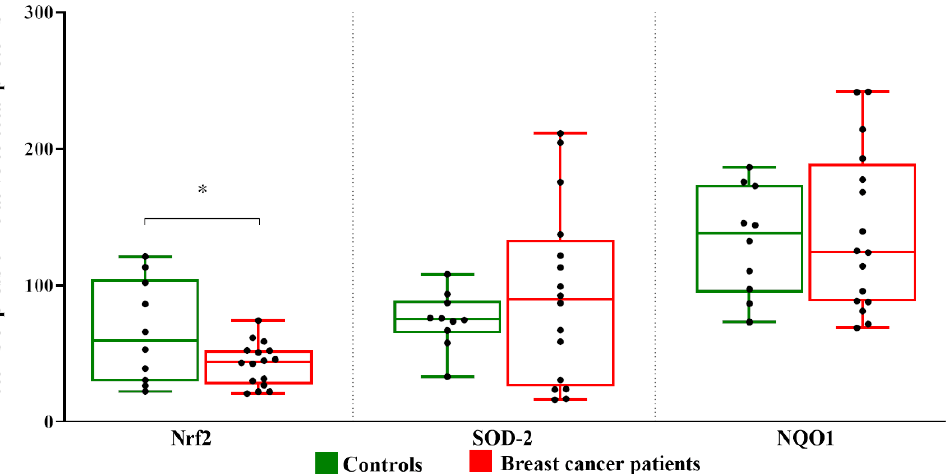
Figure 3. Expression level of Nrf2, SOD-2, and NQO1 proteins in follicular fluids. Densitometric analysis of the immunoreactive bands performed in three independent experiments. After densitometric analysis, western blot signals of the target proteins are normalized to the total amount of protein in each lane. The box plots show medians and whiskers. Significance (* p < 0.05).